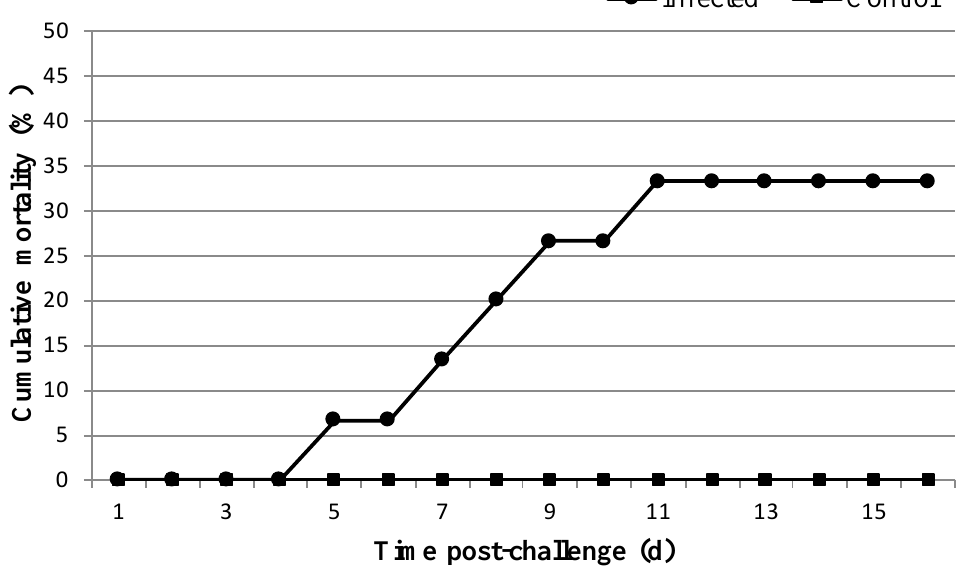
Figure 2. Cumulative mortality in infected and control S. senegalensis groups after challenge with P. damselae subsp. piscicida ( n = 15 per group).